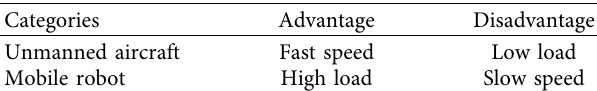
Figure 2: Applications of robotics in various felds. Table 1: Relevant characteristics of unmanned aircraft and mobile robots.